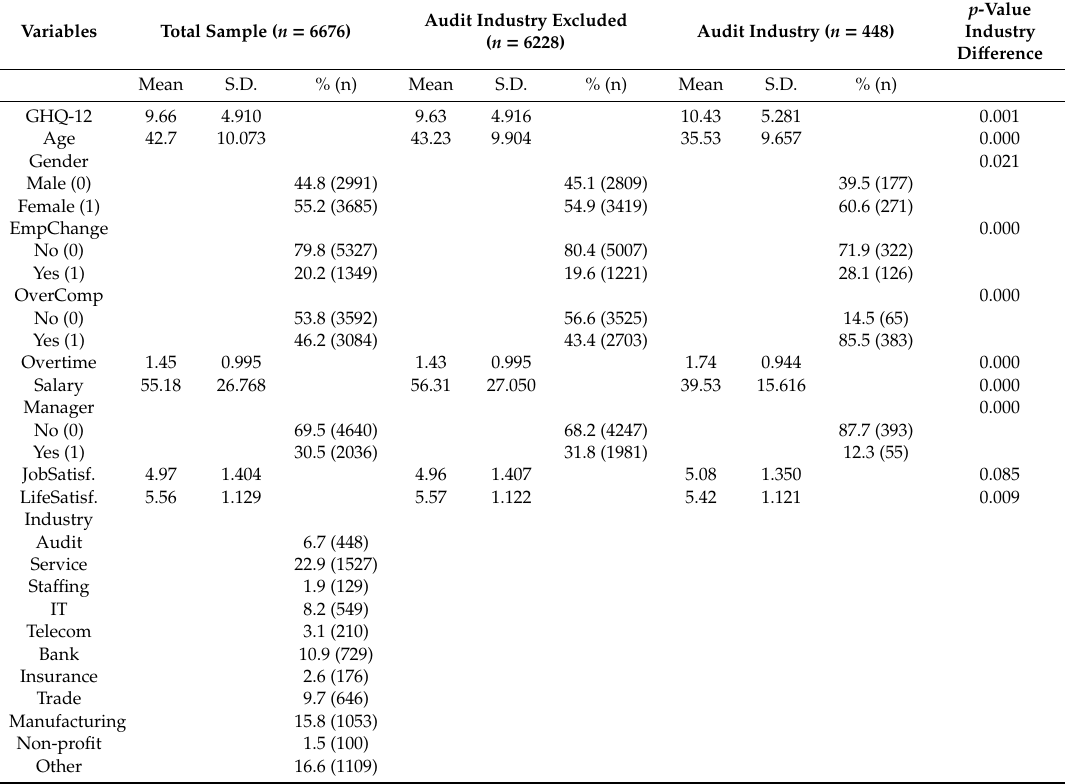
Table 1. Descriptive statistics and audit industry di ff